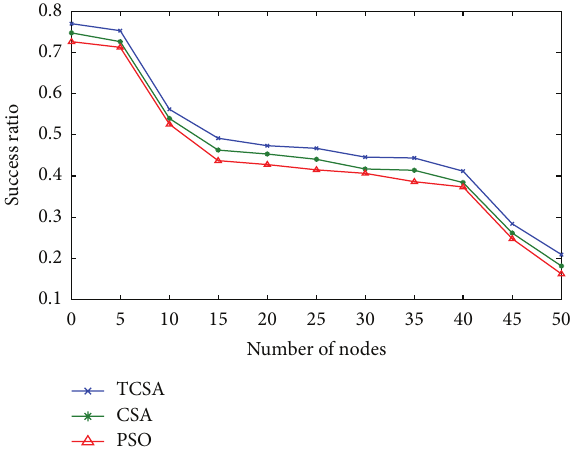
Figure 3: Plot of the real-time packet delivery ratio.